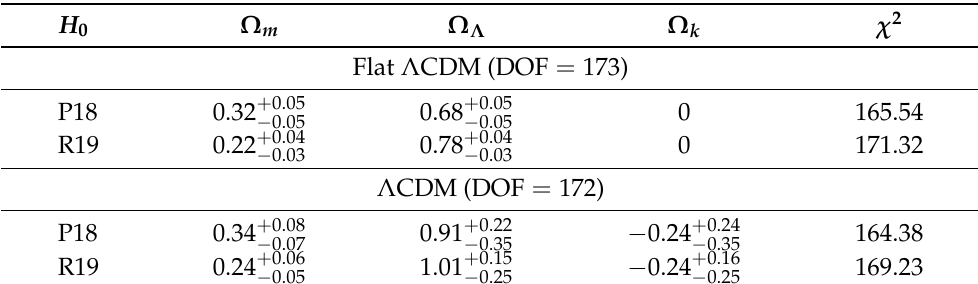
Table 9. Best-fit parameters with 1– σ uncertainties for the various cosmological cases discussed in this work. The last column lists the values of the χ 2 . H 0 is fixed to the values given by Ref. [122,222], respectively the Planck and Riess expectation